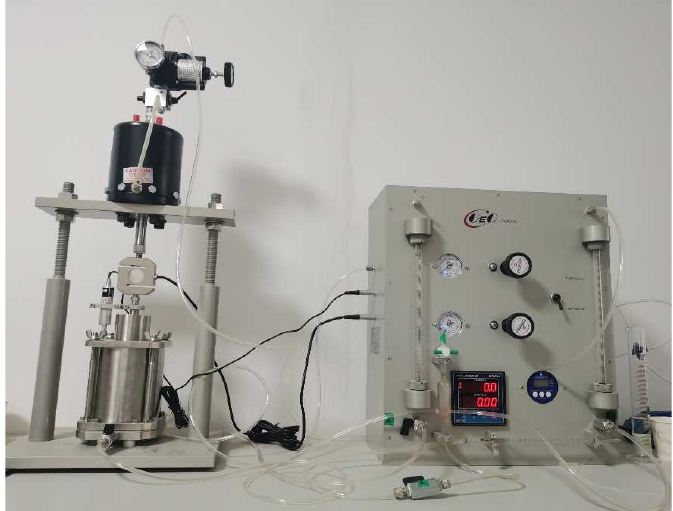
Figure 3. SD-SWCC pressure plate tester test drawing.